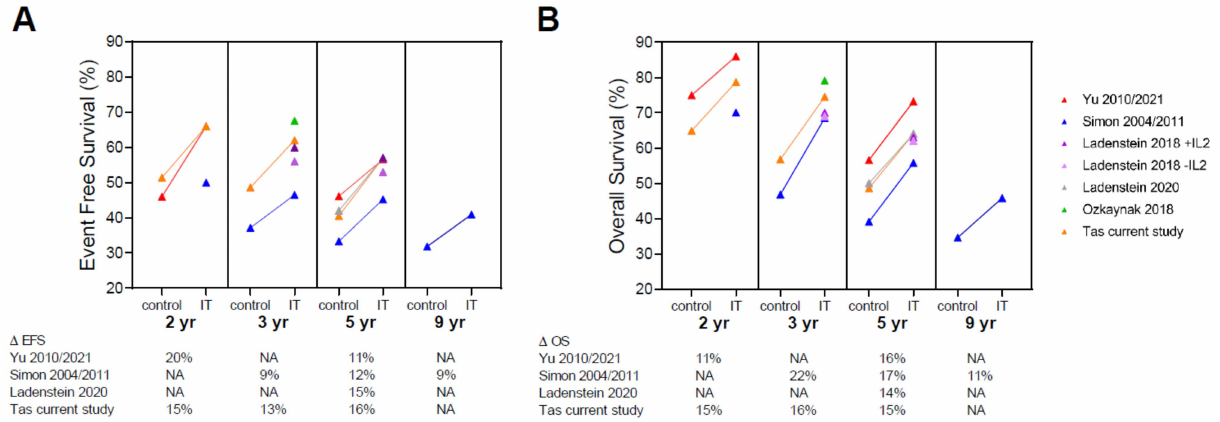
Figure 3. Event free and overall survival in literature. Event free survival (EFS; A ) and overall survival (OS; B ) of published cohorts at different times of follow-up. The X-axis shows the time of follow-up. Within each follow-up moment, the left side shows the EFS or OS of patients treated without anti-GD2 immunotherapy (control) and the right side of patients treated with immunotherapy (IT). When an article contained both patients treated with and without immunotherapy the two groups are connected by a line. Below the graph the difference ( ∆ ) in EFS or OS is given for these articles.